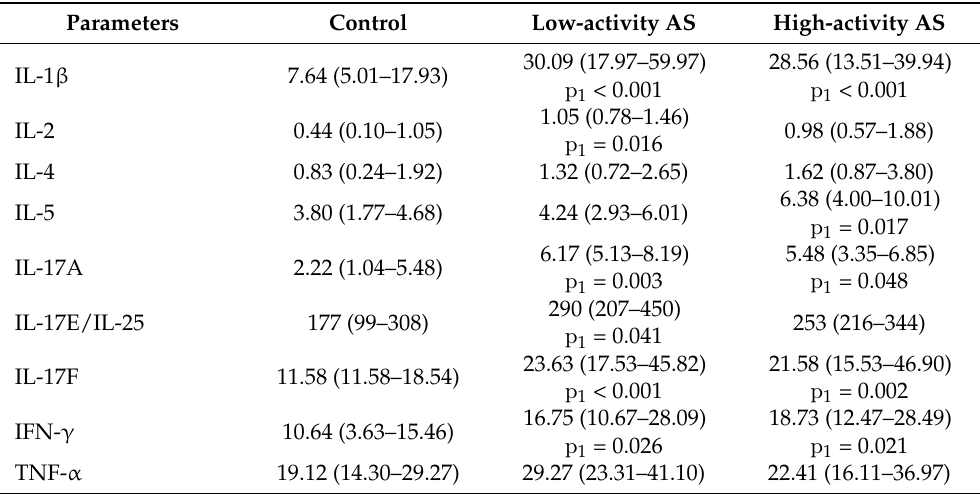
Table 8. Serum cytokine level (pg/mL) in activity-driven AS patients ( Ме (C 25 –C 75 )).